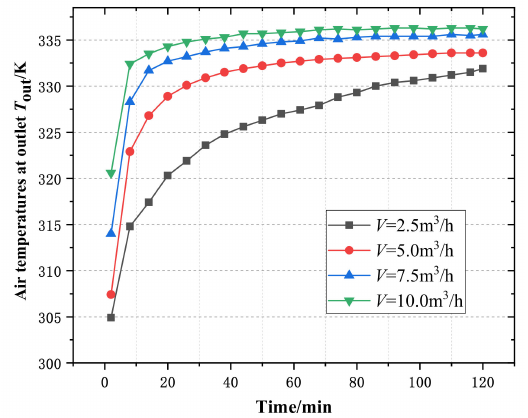
Figure 9. Variation of air temperatures at the outlet of dehumidifier with time at different inlet wet air flow